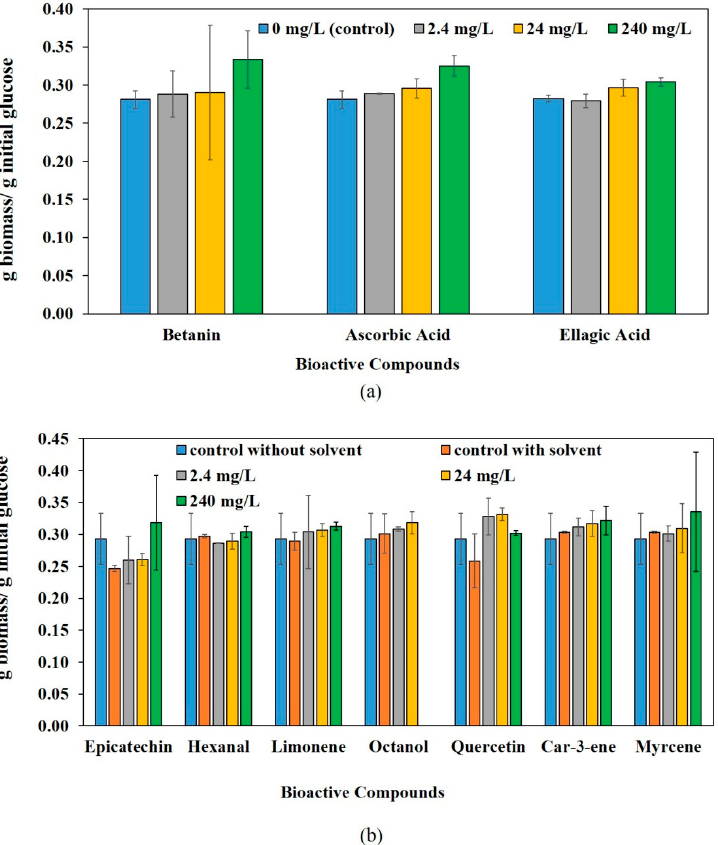
Figure 2. The effect of bioactive compounds on A. niger biomass yield. ( a ) The compounds that had control without bioactive compound and solvent (ellagic acid had NaOH solution as a solvent; however, since the initial pH of the medium was at the required pH of cultivation, the control condition was the same as betanin and ascorbic acid). ( b ) The compounds that had a solvent other than water had two control (one control without bioactive compound and solvent and another control with solvent and without bioactive compounds). Table 2. Statistical analysis results showing significant difference between the effect of different concentrations of each bioactive compound on A. oryzae biomass yield.